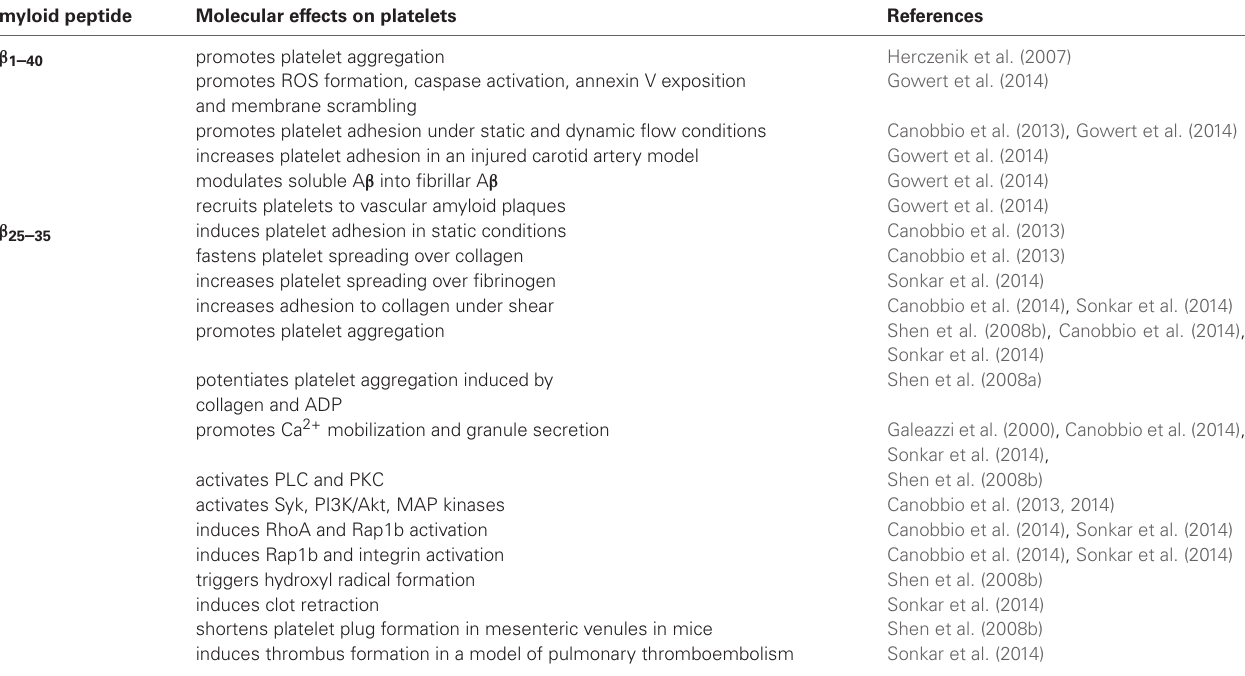
Table 1 | Principal molecular effects of amyloid peptides on platelets . Amyloid